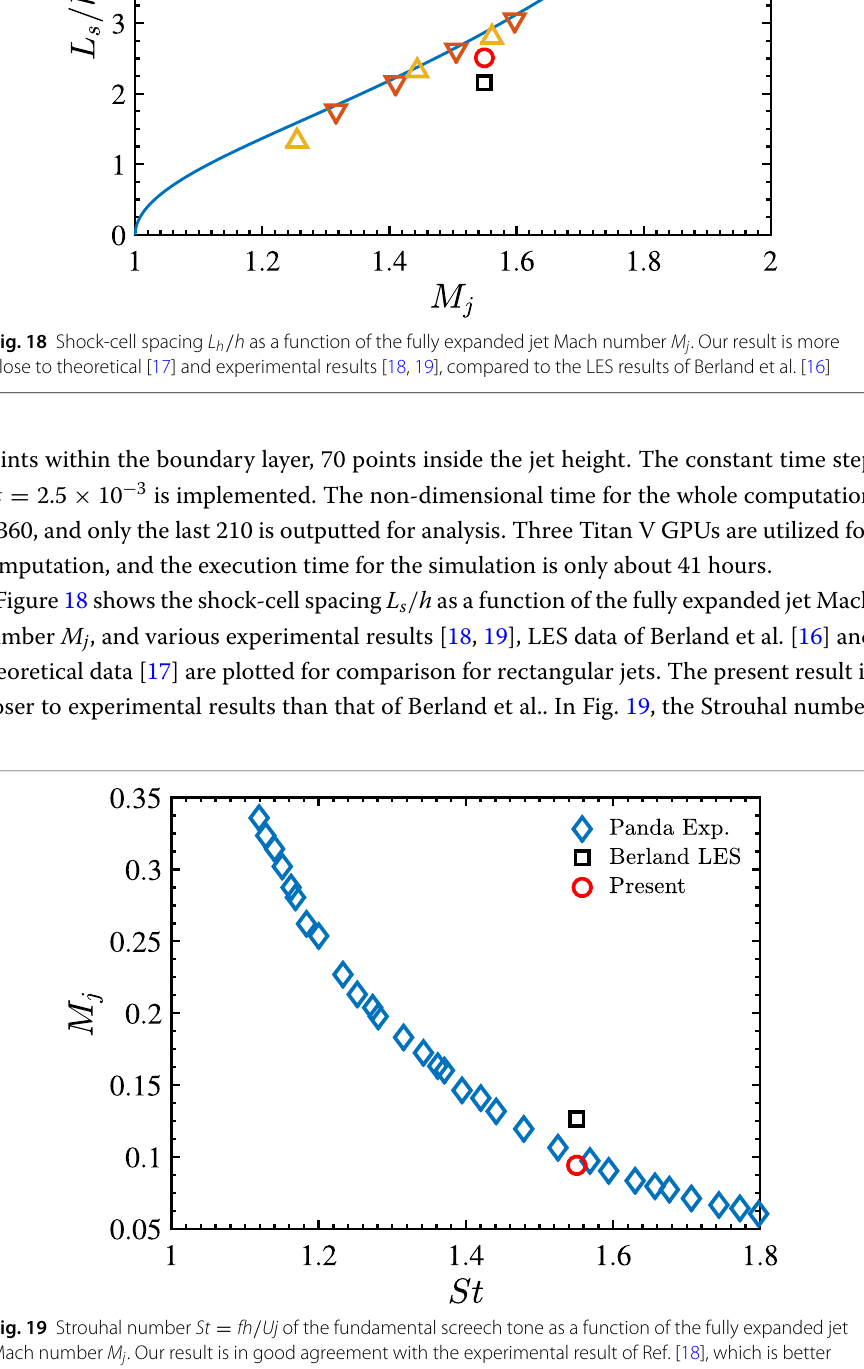
Fig. 19 Strouhal number St = fh / Uj of the fundamental screech tone as a function of the fully expanded